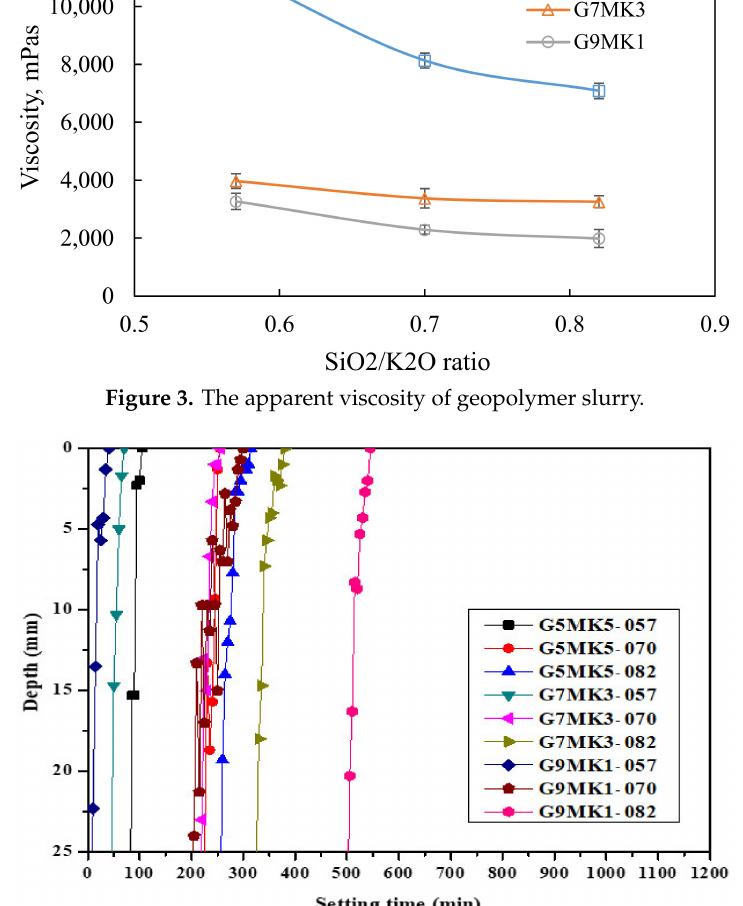
Figure 4. Setting time of geopolymer slurry prepared with di ff erent SiO 2 / K 2 O molar ratio